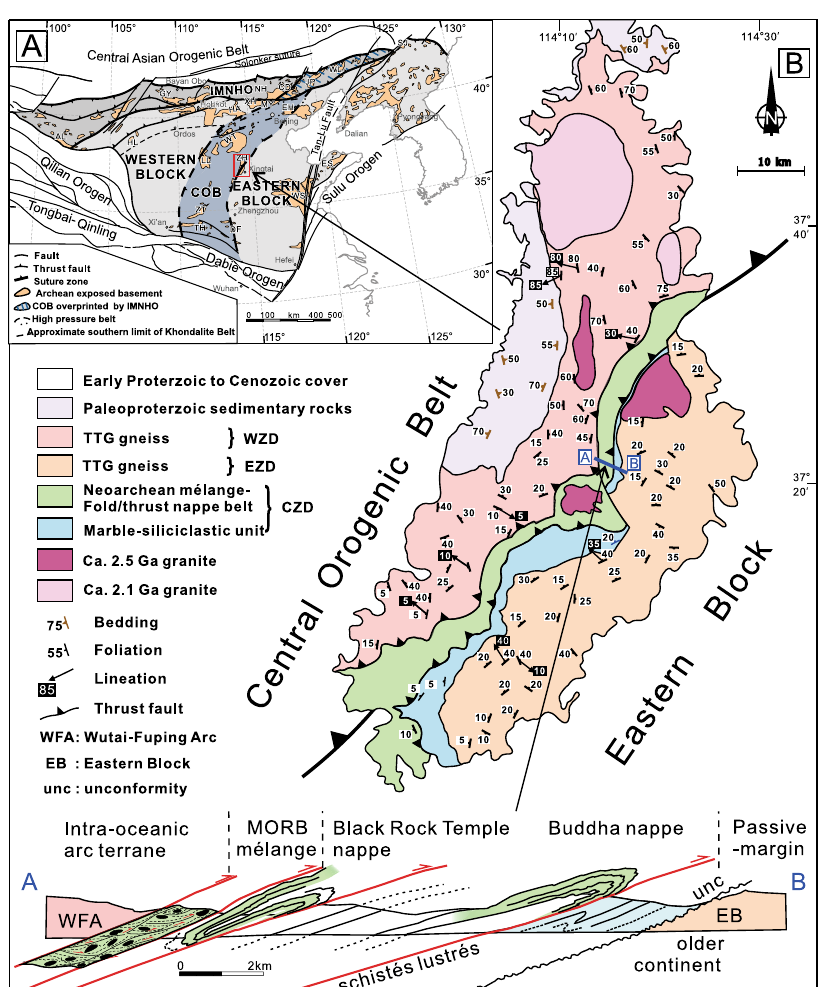
Fig. 1 Geological map and tectonic setting of the area studied. a Map showing main Precambrian tectonic divisions of the North China Craton (modi fi ed from Kusky et al. 13 ). Red box shows location of Zanhuang Complex, illustrated in ( b ); ( b ) Map showing the main tectonic zones of the Zanhuang Complex, with simpli fi ed pro fi le (no vertical exaggeration) along fold nappe/thrust belt ( a , b ), showing the relative positions of the Eastern Block (EB) basement and unconformably overlying passive margin. The forearc upper-plate units include the Buddha nappe, thrust over the passive margin along a major thrust (suture) marked by the schistes lustrés , and this is succeeded structurally upwards by the Black Rock Temple nappe, which is overthrust by the Wutai/ Fuping arc (WFA) system along the MORB-bearing ophiolitic mélange zone. WZD Western Zanhuang Domain, EZD Eastern Zanhuang Domain,